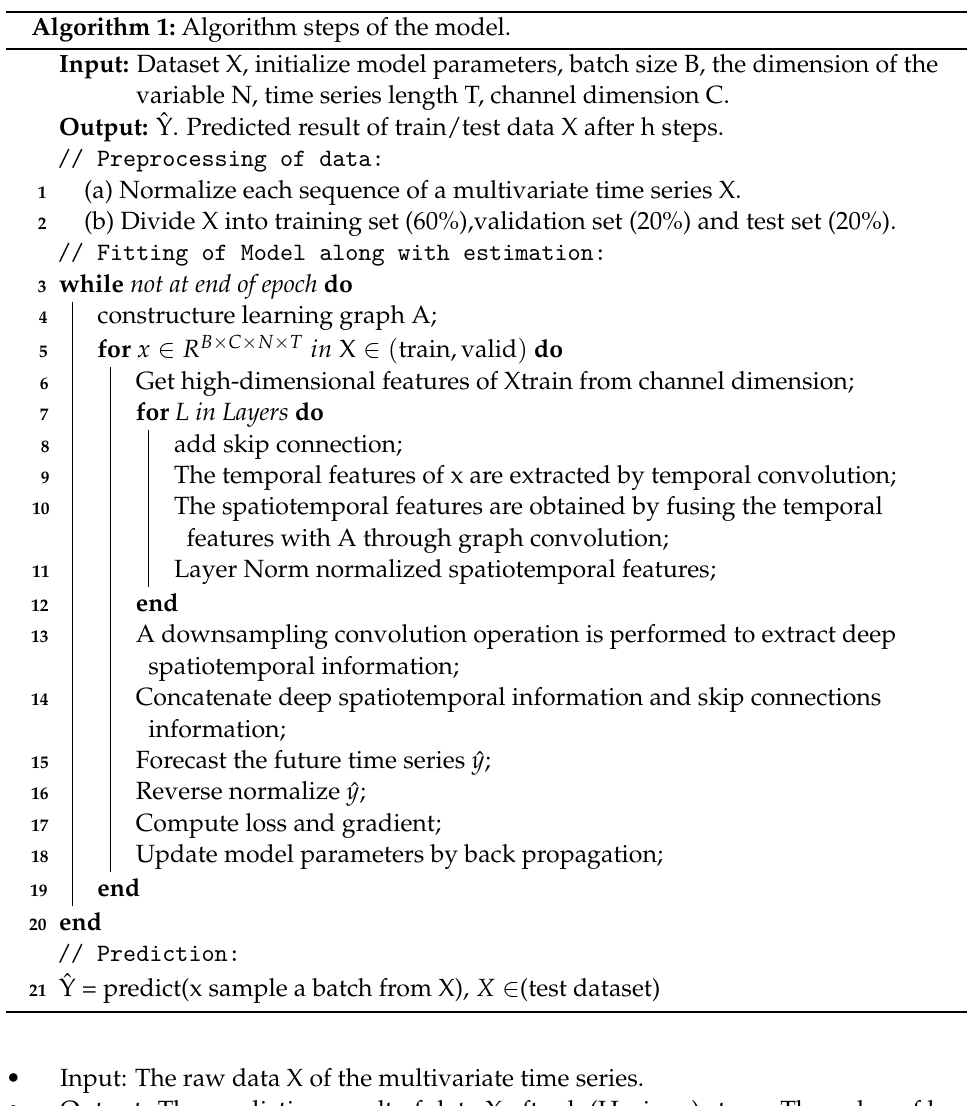
Algorithm 1: Algorithm steps of the